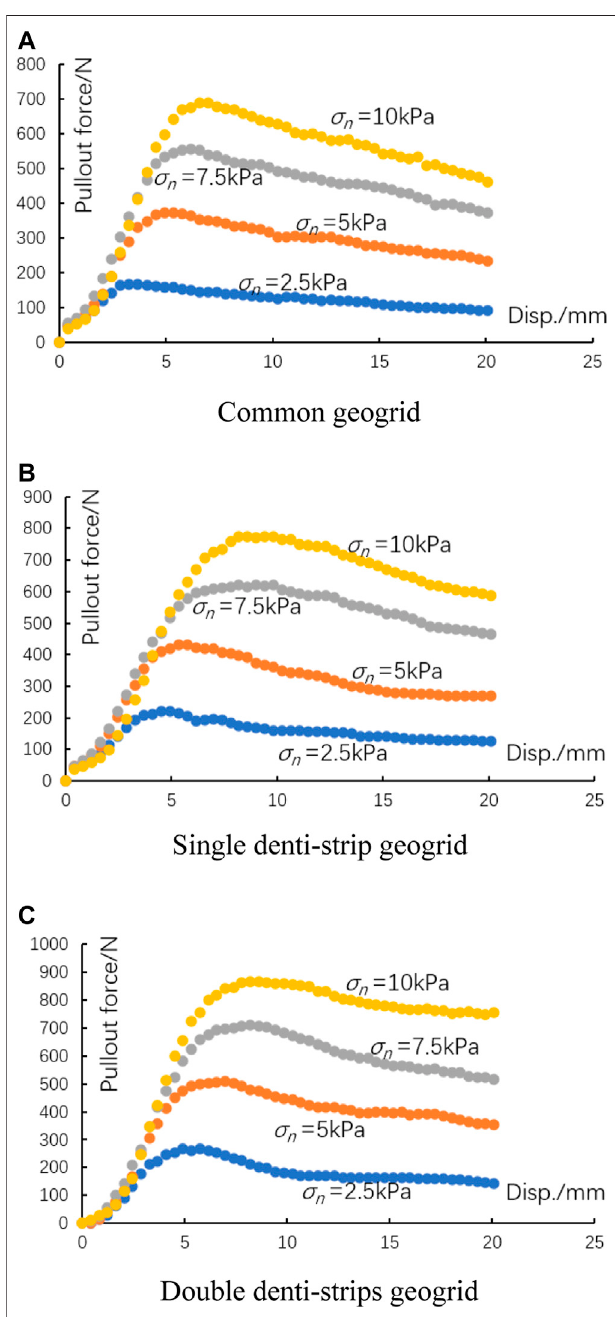
FIGURE 6 | Relationship between pullout force and displacement. (A) Common geogrid; (B) Single denti-strip geogrid; (C) Double denti-strips